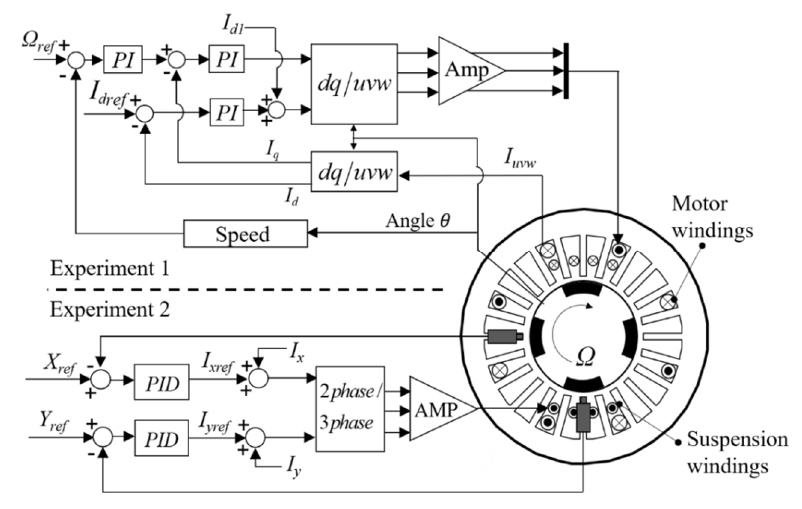
Figure 6. The signal flow for the experiments using excitation forces generated by the motor windings (Experiment 1) and the suspension windings (Experiment 2), respectively.